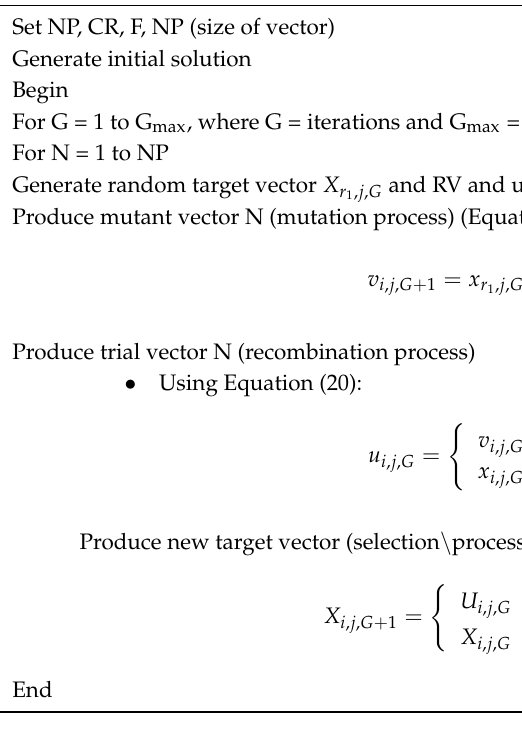
Algorithm 1. Pseudocode of the proposed